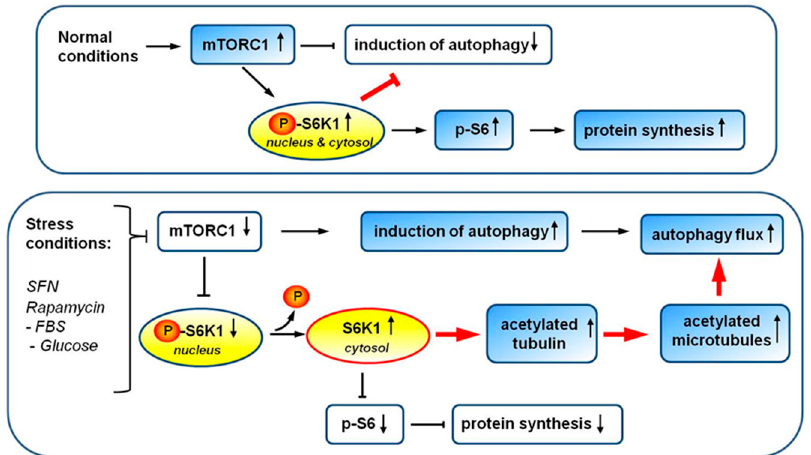
Figure 11. The model of S6K1 role in autophagy under standard (upper panel) and stress (lower panel) conditions. Blue background, activation of a protein/process; white background, inhibition of a protein/process.